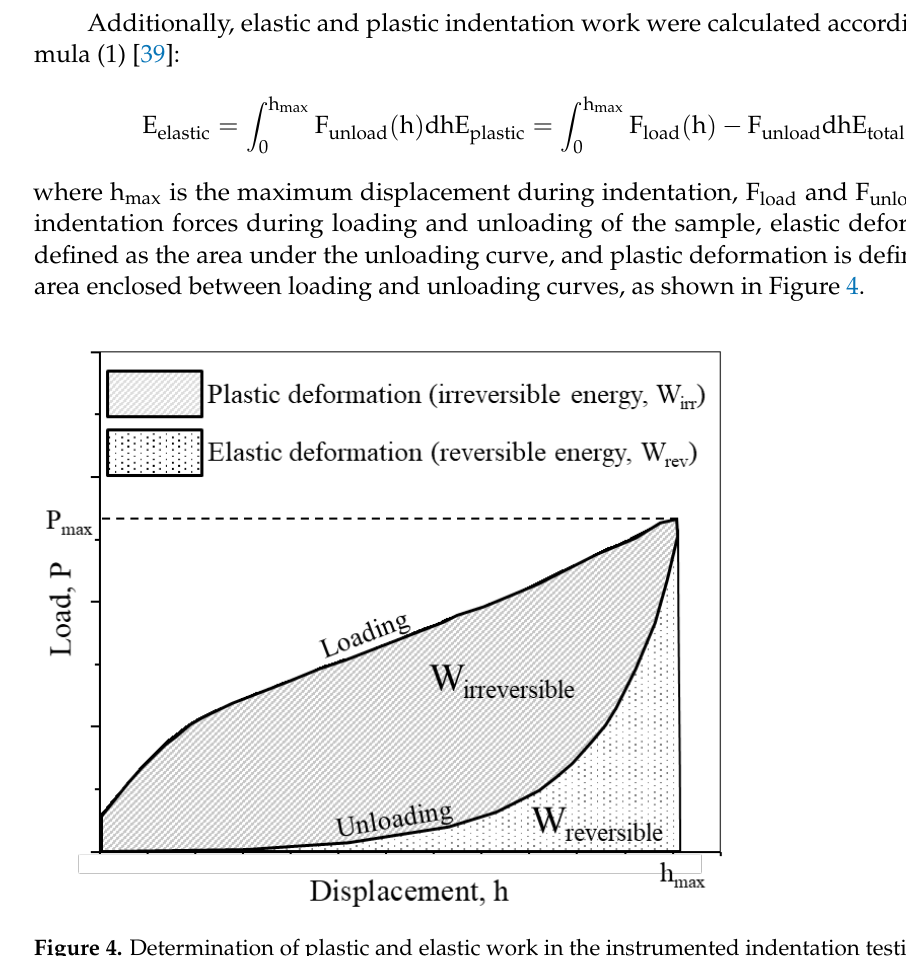
Figure 3. Influence of the number of samples on the confidence interval around the mean value of indentation hardness for basal faces at a penetration depth of 200 nm (confidence interval of 95%).